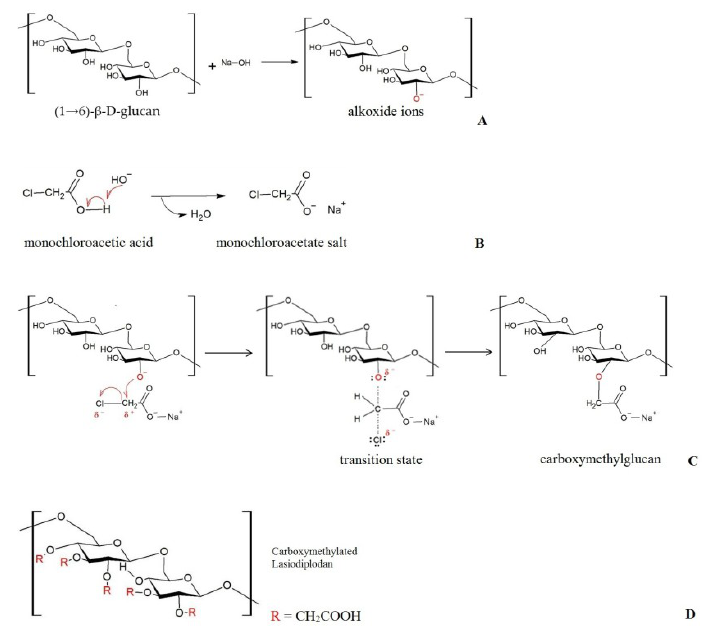
Figure 1. Illustrative representation of the reaction mechanism of carboxymethylation of lasiodiplodan. Formation of alkoxide ions ( A ), conversion of monochloroacetic acid to sodium monochloroacetate salt ( B ), nucleophilic bimolecular substitution (SN2) ( C ), and carboxymethylated lasiodiplodan ( D ). The positions shown for R indicate that the carboxymethylated group could be added at C-2, C-3, and C-4 positions on the glucose moieties.